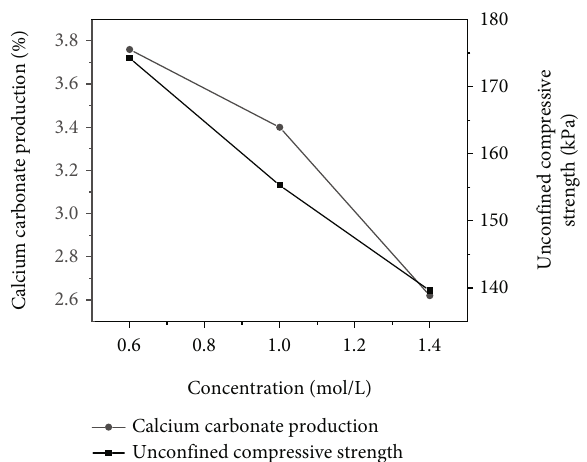
Figure 12: Comparison of calcium carbonate production and uncon fi ned strengths of calcium chloride-cured samples.